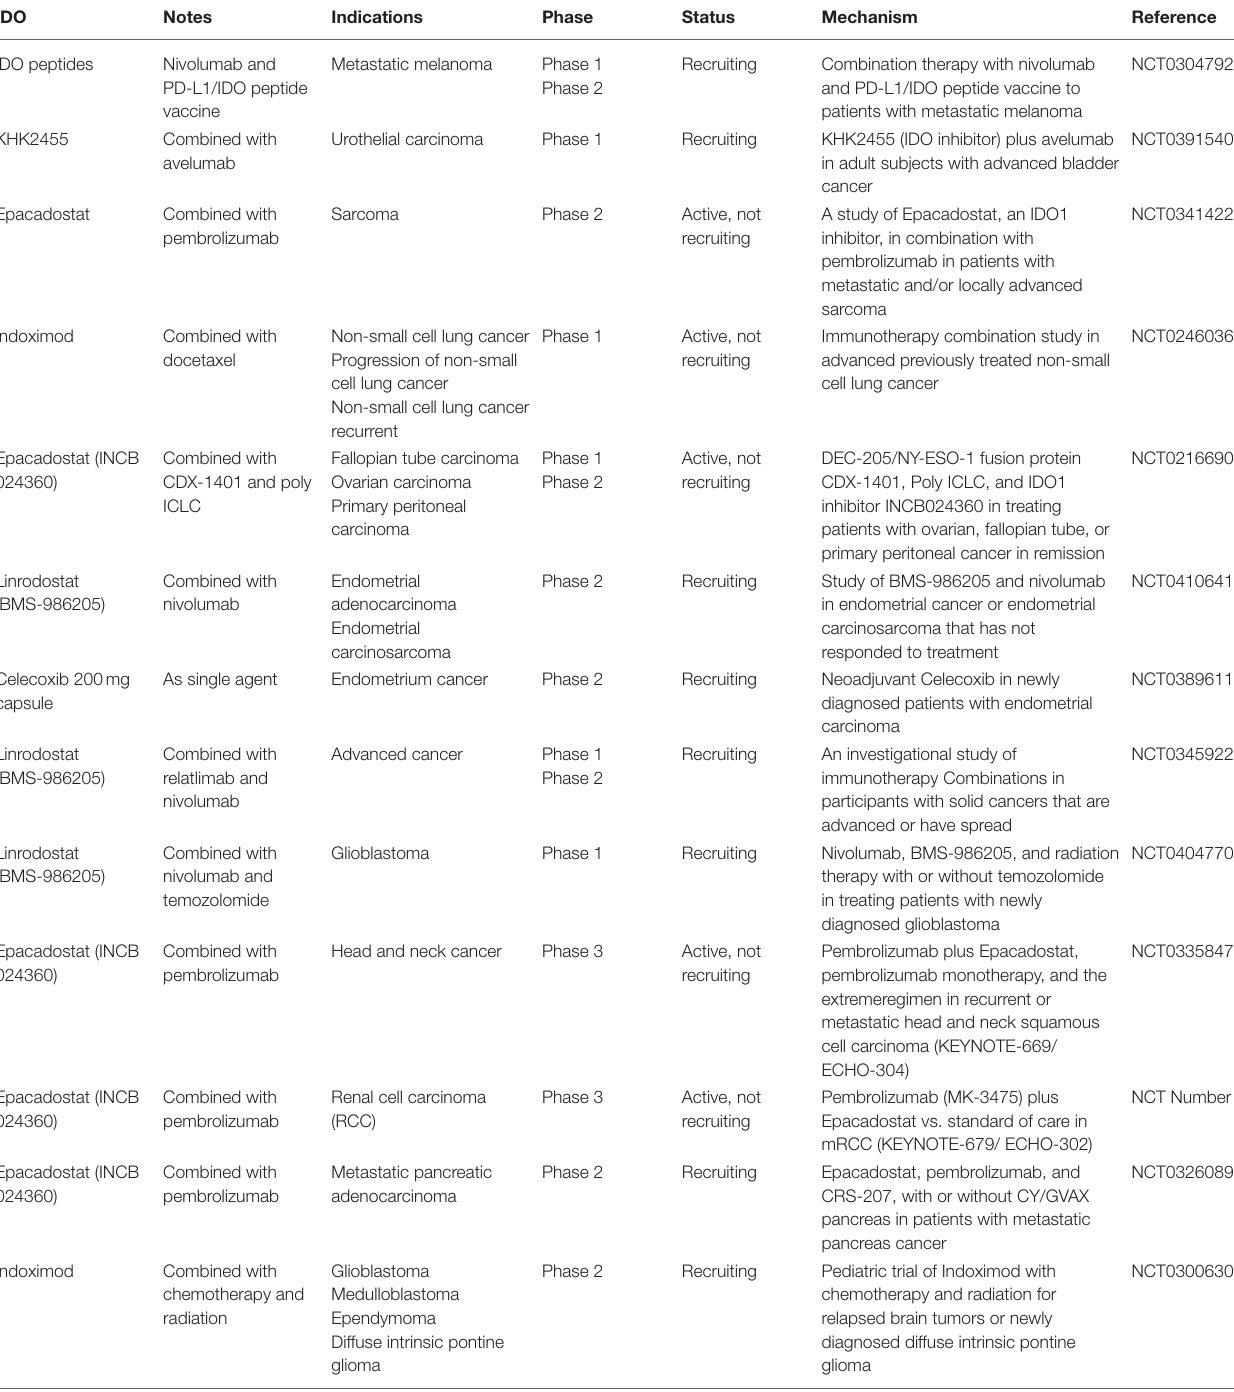
TABLE 2 | List of current investigated IDO1 inhibitors. Information about the above trials can be accessed at